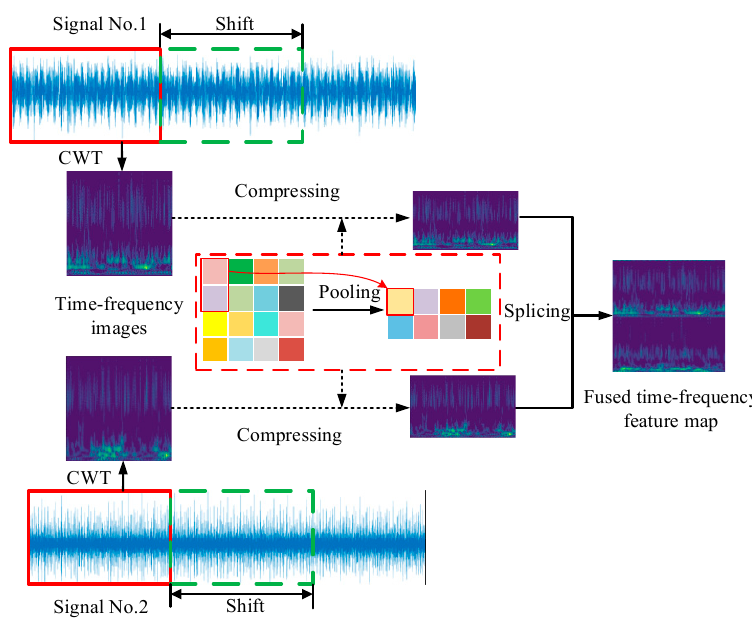
Figure 4. The flowchart of feature enhancement and feature fusion strategy.